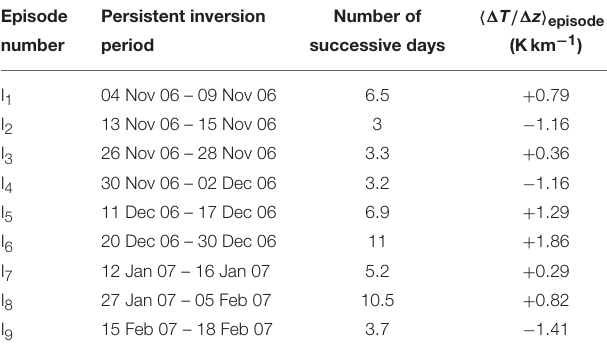
TABLE 2 | Persistent inversions detected using criterion